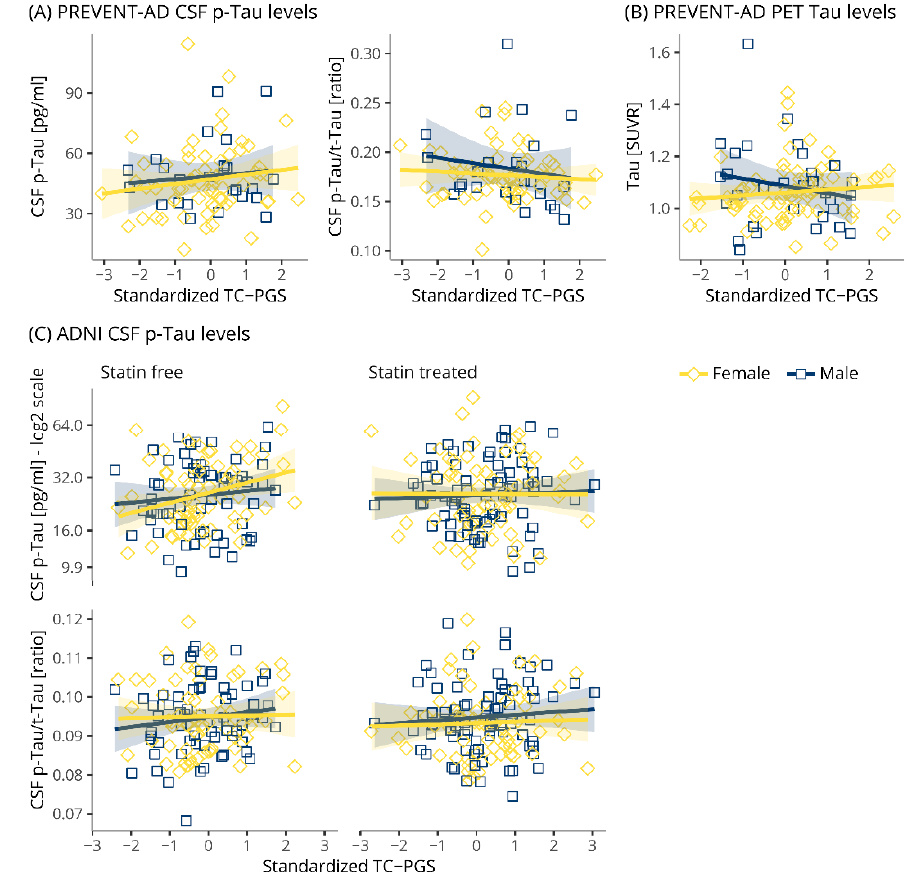
Figure 4. Associations of TC-PGS with biomarkers of TAU pathology . TAU pathology biomarkers plotted against TC-PGS and assessed by multiple linear regressions. ( A ) PREVENT-AD CSF levels of p-Tau and its ratio with t-Tau levels. ( B ) PREVENT-AD TAU brain levels, as assessed by PET. ( C ) ADNI CSF levels of p -Tau and its ratio with t-Tau. Shaded areas indicate 95% confidence intervals.